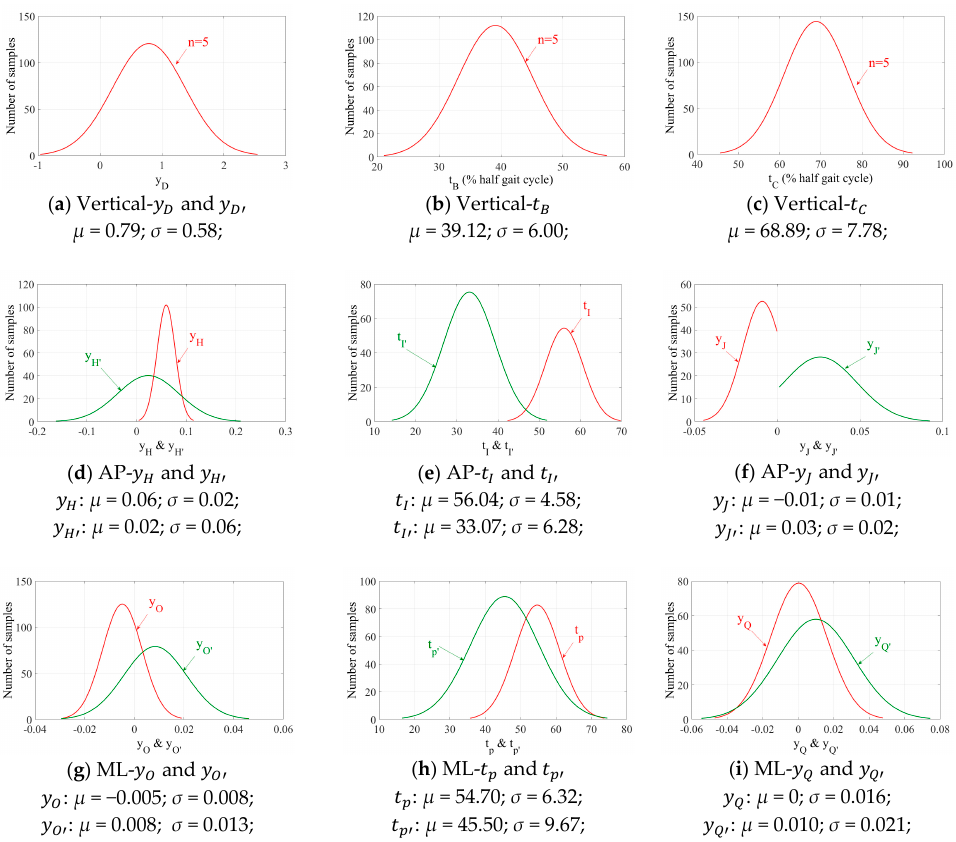
Figure 4. The normal distribution fit representing polynomials’ parameters. Table 1. Twin polynomial method (TPM) polynomial parameters.